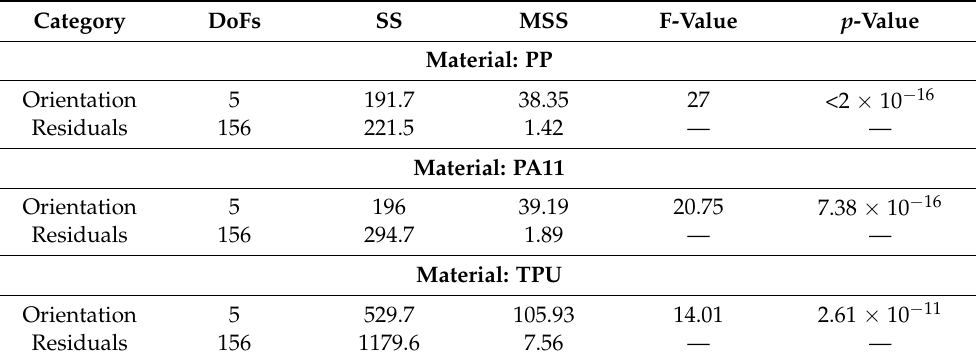
Table 5. A one-way ANOVA test for the different materials (DoFs—degrees of freedom, SS—the sum of squares, MSS—the mean of the sum of squares, F-value—test statistic from the F-test, p -value— p - value of the F-statistic). Table 6. A two-way ANOVA test for the different materials (symbols the same as previously).